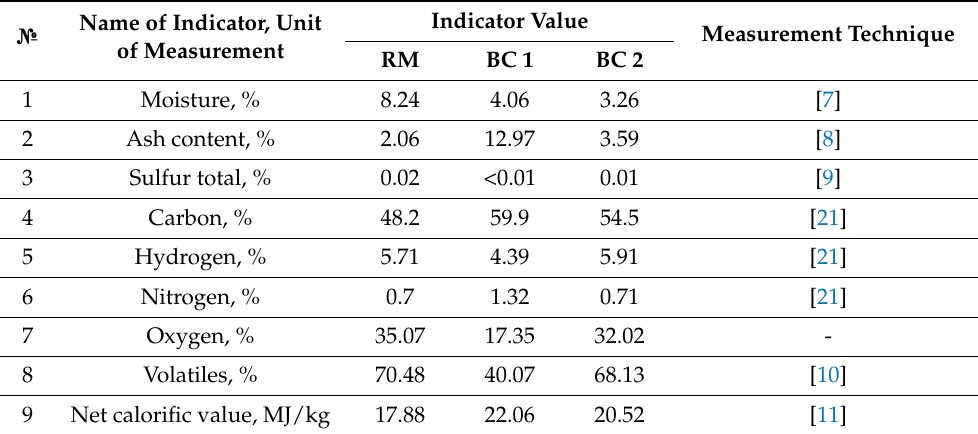
Table 4. Characteristics (on a dry basis) of the initial sunflower husk and biochar obtained by two torrefaction